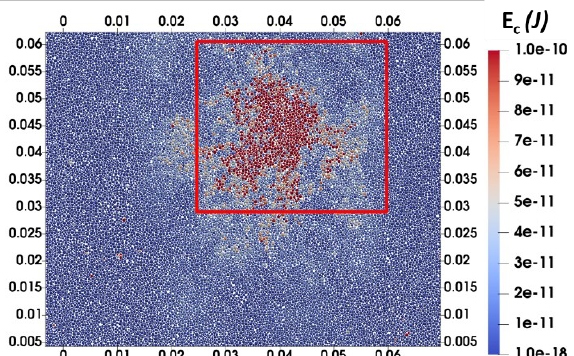
Fig. 1 . Screenshot of the presented burst. The particles are colored in function of their kinetic energy. The box used for the delimitation of the burst is superimposed to the screenshot. It takes into account the slight displacement of the burst on the right direction (displacement not shown here).